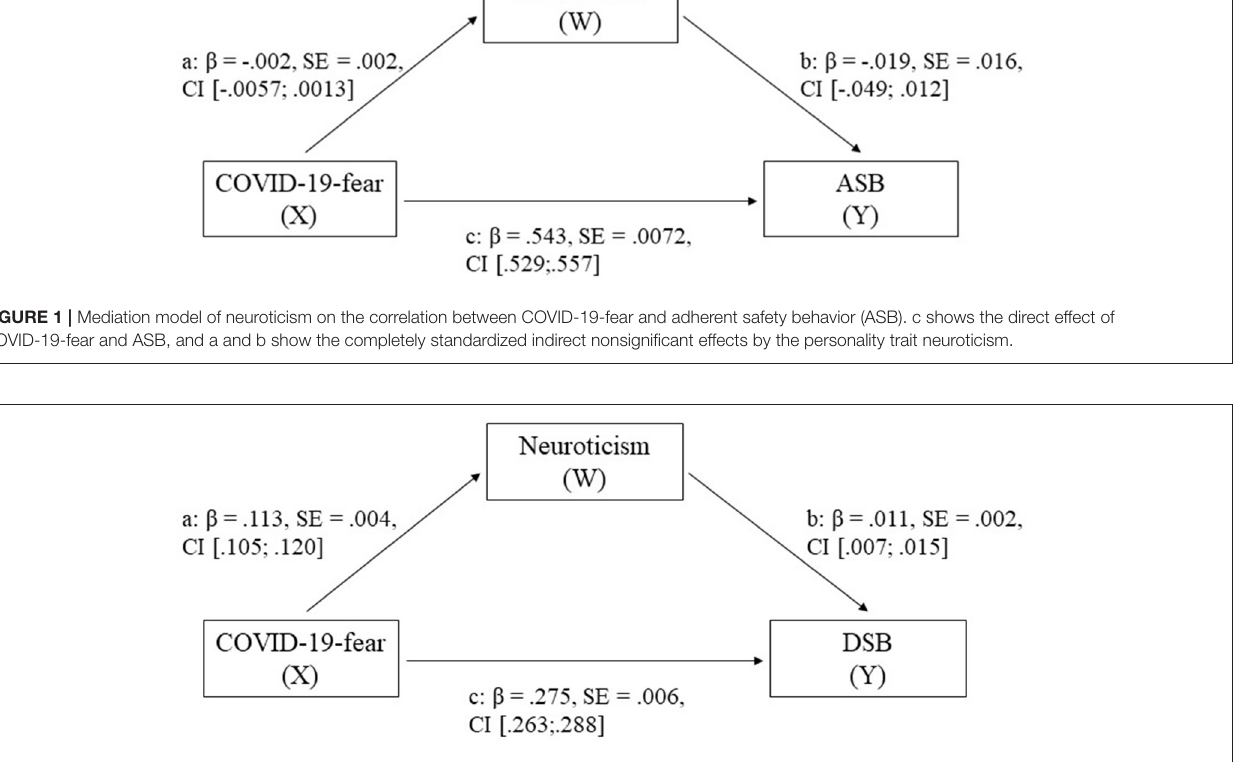
FIGURE 2 | Mediation model of neuroticism on the relationship of COVID-19-fear and dysfunctional safety behavior (DSB). c shows the direct effect of COVID-19-fear and DSB, and a and b show the completely standardized indirect significant effects by the personality trait